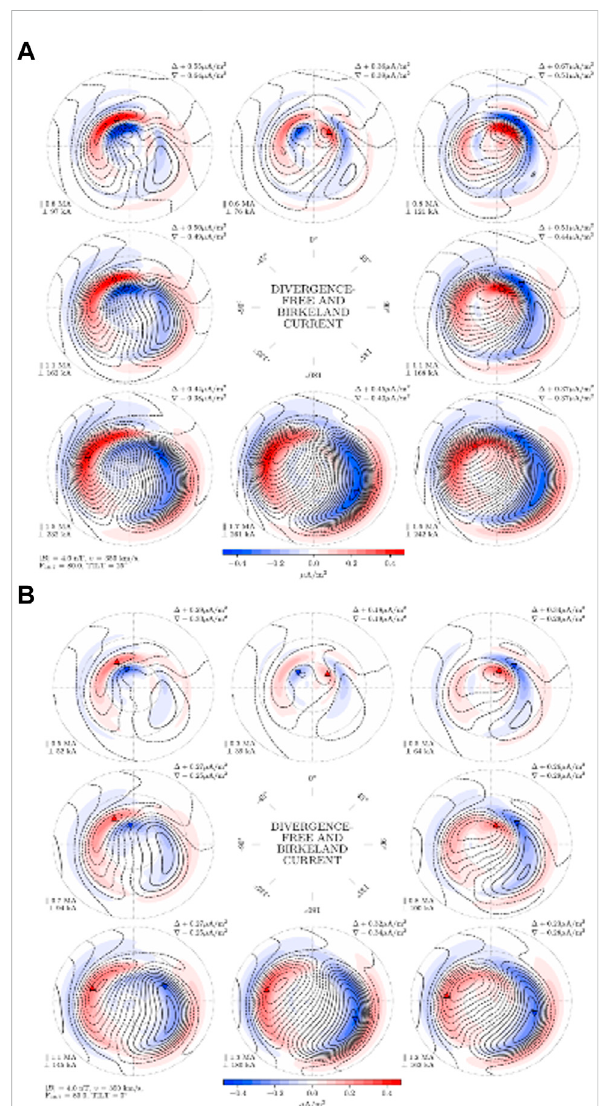
FIGURE 2 Field-aligned current (red and blue color) and the ionospheric Hall currents (black contours), in the Northern Hemisphere in summer (A) and winter (B) seasons (Laundal et al., 2018). The peak upward and downward current densities are listed in the top rightcorners.Totalupwardcurrent,labeledby (cid:1) ,isgiveninthelower left corners in units of megaampere. The ionospheric currents are labeled by ┴ in units of